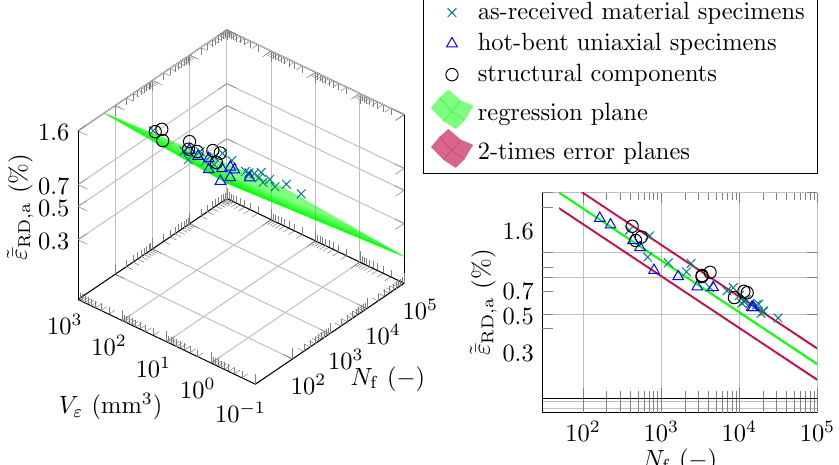
Figure 12. Three-dimensional and two-dimensional ˜¯ ε RD,a - V ε - N f fatigue diagrams by applying the CH ε V with regression parameters from results of low-cycle fatigue tests of the hot-bent uniaxial